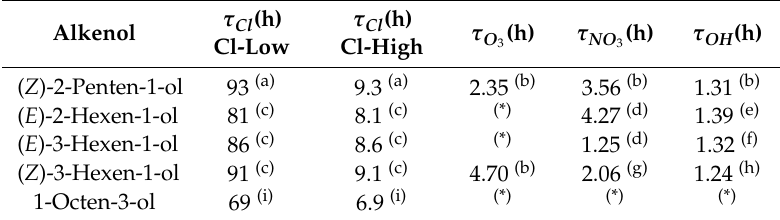
Table 2. Calculated atmospheric lifetimes for the reactions of the studied unsaturated alcohols with Cl, O 3 , NO 3 , and OH. Cl-low and Cl-high refer to [Cl] of 1 × 10 4 and 1 × 10 5 atoms · cm − 3 , respectively.